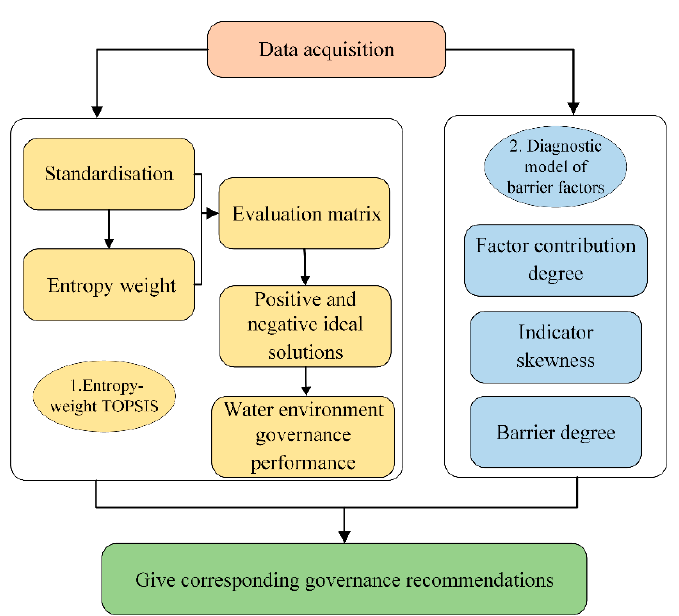
Figure 4. Schematic diagram of the methodology